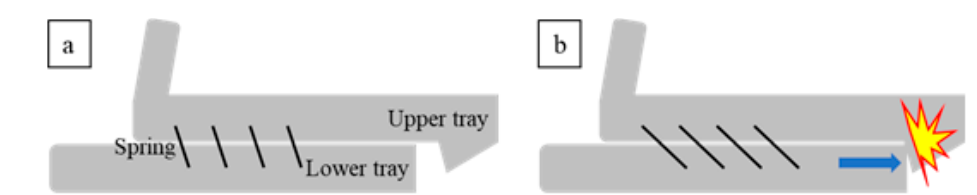
Figure 1. Mandibular advanced device (MAD): ( a ) conventional type and ( b ) prototype of the proposed MAD.